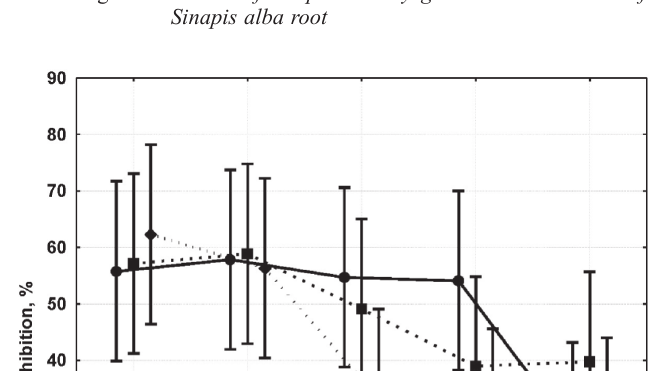
Fig. 3 – Results of the preliminary growth inhibition test of Sinapis alba root